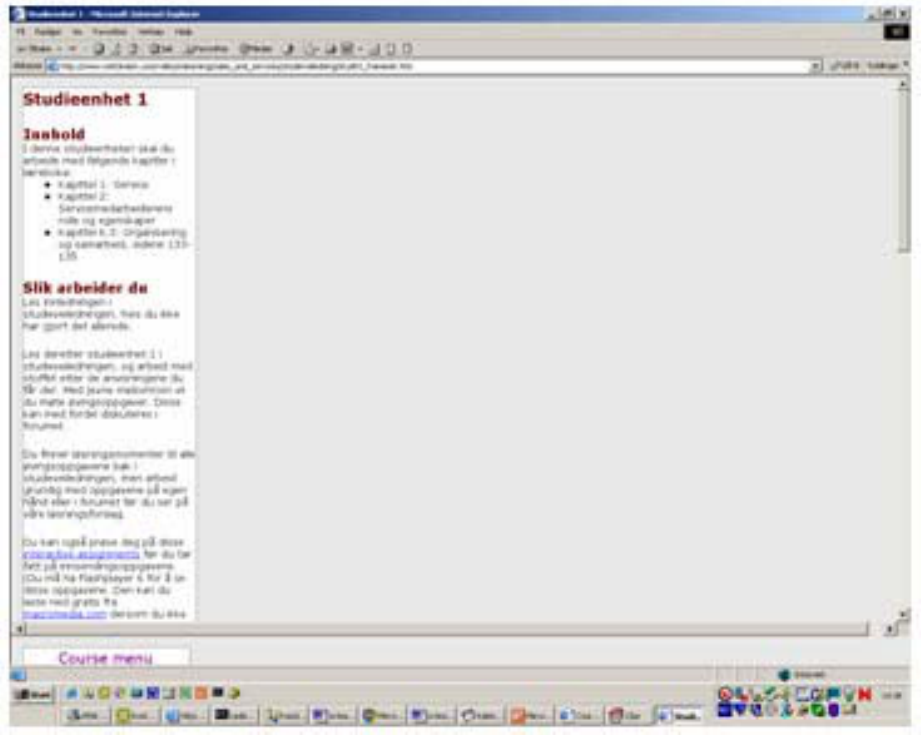
Figure 3. Screen shot from a PC of the specific version of the course, Sales and